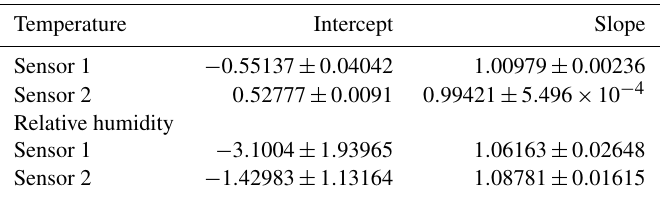
Figure 3. (a) UAV-UG1. (b) Telemetry screen for FPV real-time on-screen display of the UAV-UG1 performance. (c) DJI Mavic 2 Pro during flight. (d) Ground meteorological measurements. Table 3. Intercept and slope coefficients for the calibration of UAV-UG1 and UAV-UG2 meteorological